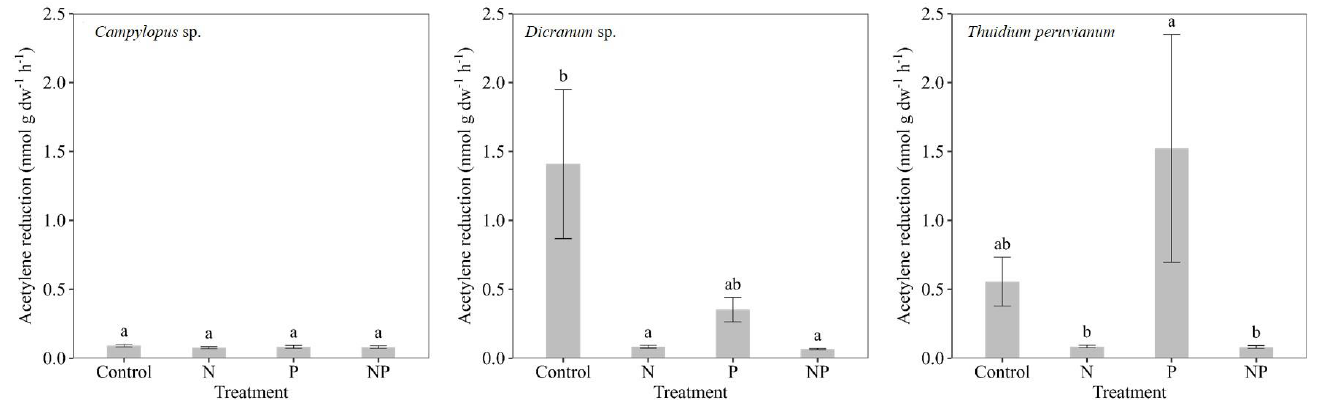
Figure 3. Mean nitrogenase activity (acetylene reduction in nmol g dw − 1 h − 1 ; ±SE, n = 24, across all time points) of the whole experiment in response to nutrient additions (control, nitrogen (N), phos- phorus (P) and nitrogen and phosphorus (NP)) in three moss species ( Campylopus sp., Dicranum sp. and Thuidium peruvianum ) collected in a tropical montane cloud forest in south-eastern Peru. Different letters (a/b/ab) show statistically significant (Tukey HSD test) differences between treatments.